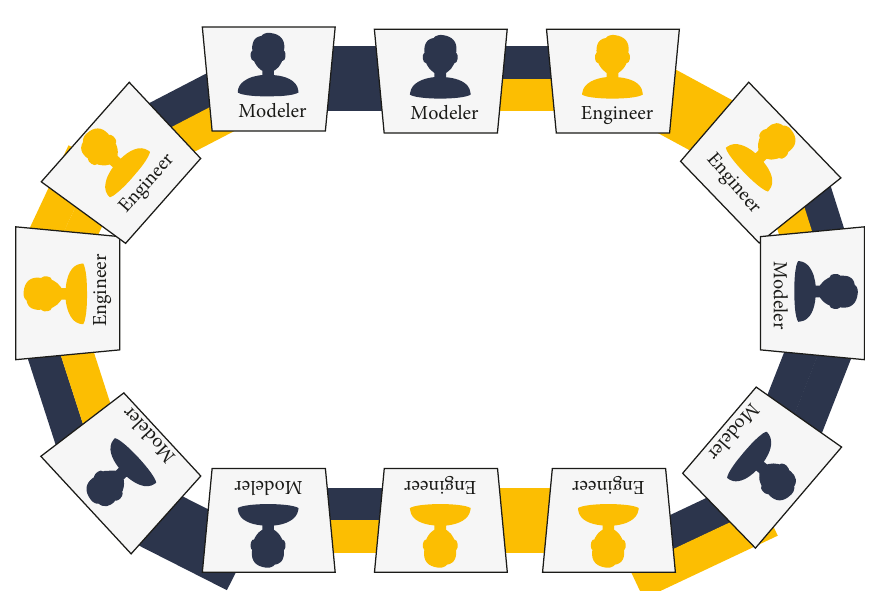
Figure 3: Organization plan for the ideal BIM physical space, “3 pairs”.